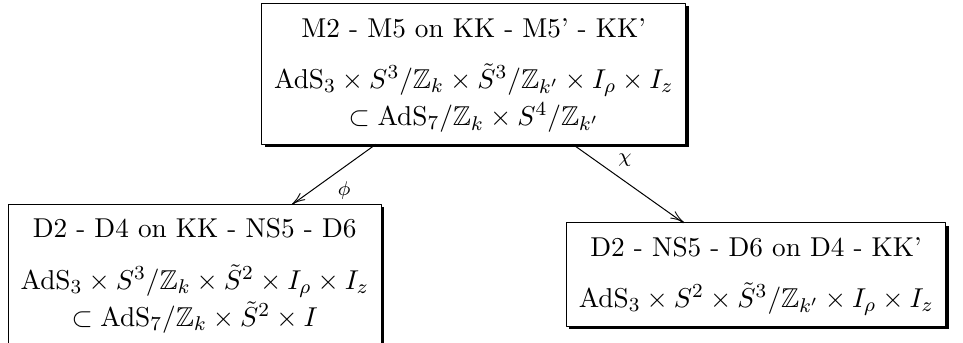
Figure 1 . Reductions of the KK’-M5’-M2-M5-KK brane system to Type IIA and their near-horizon limits. Only the reduction along φ asymptotes to AdS 7 , with the KK-M5’-KK’ system becoming